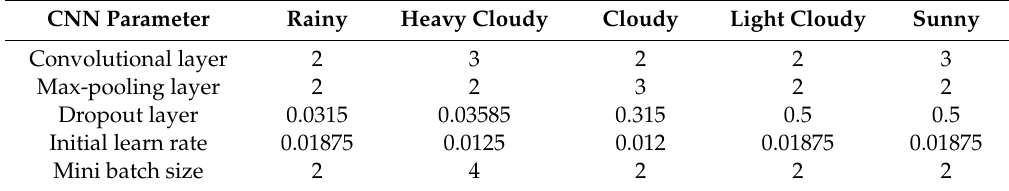
Table 2. The CNN-SSA parameters.